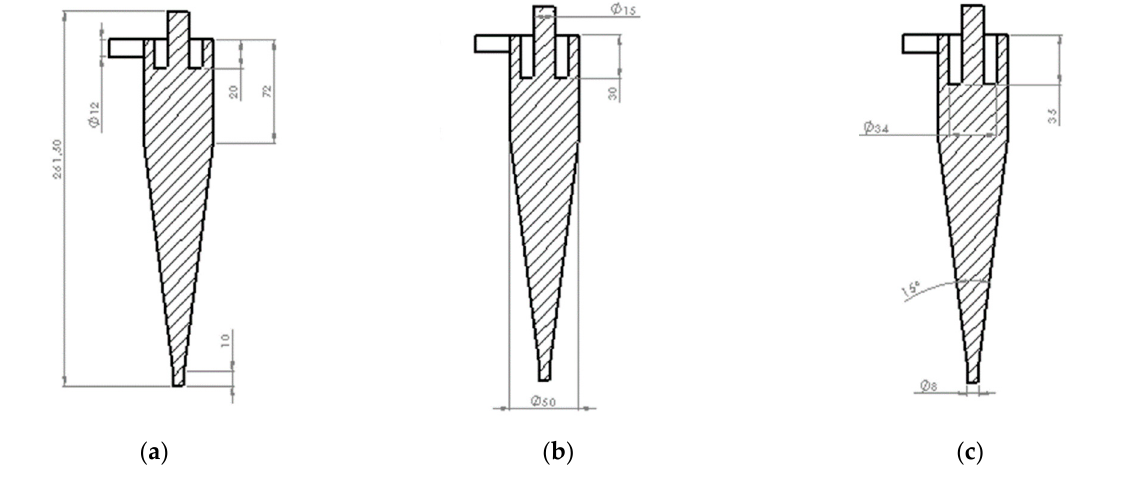
Figure 1. Geometry of hydrocyclone of base case of three vortex finder (VF) lengths, ( a ) 20 mm, ( b ) 30 mm and ( c ) 35 mm, respectively [15].